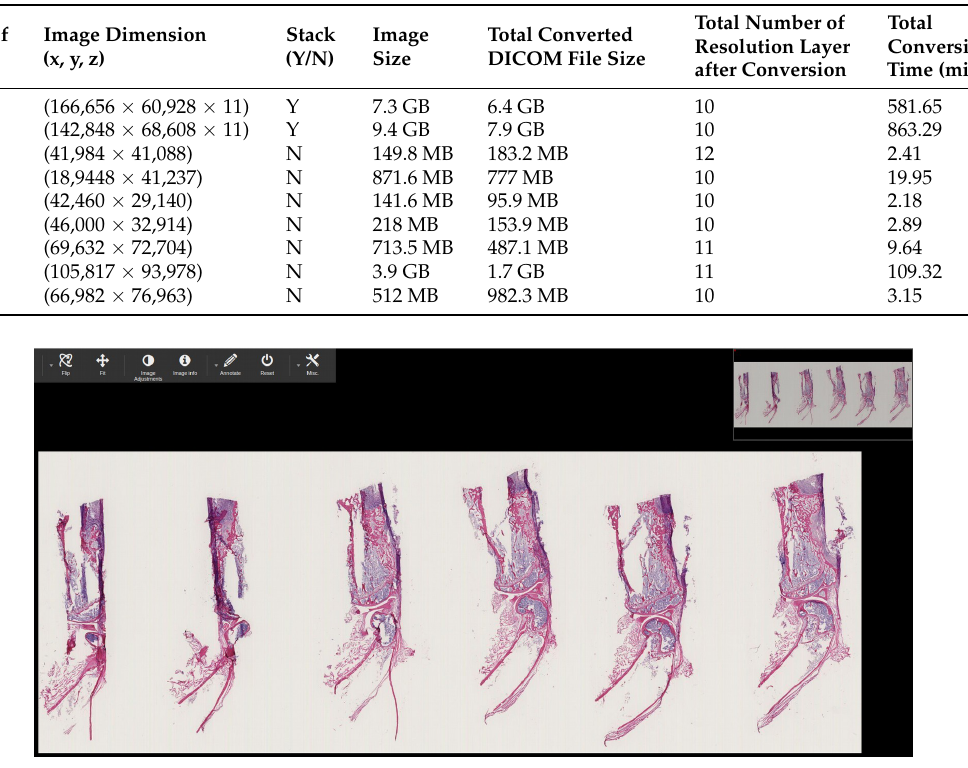
Figure 12. Screenshot of the generated DICOM file (of 11 stacks .ndpi WSI image) into Dicoogle WSI web viewer.